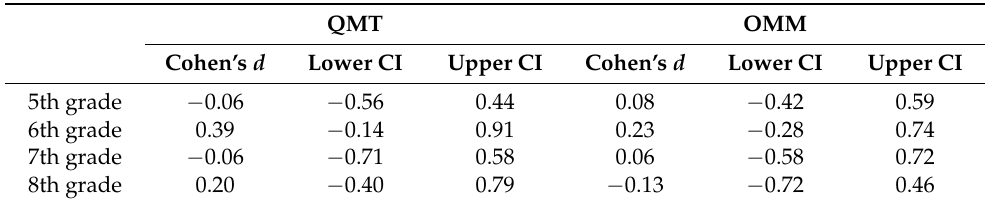
Table 4. Effect size (Cohen’s d) and 95% confidence intervals for ∆ Elaboration following QMT (left) and OMM (right) in each